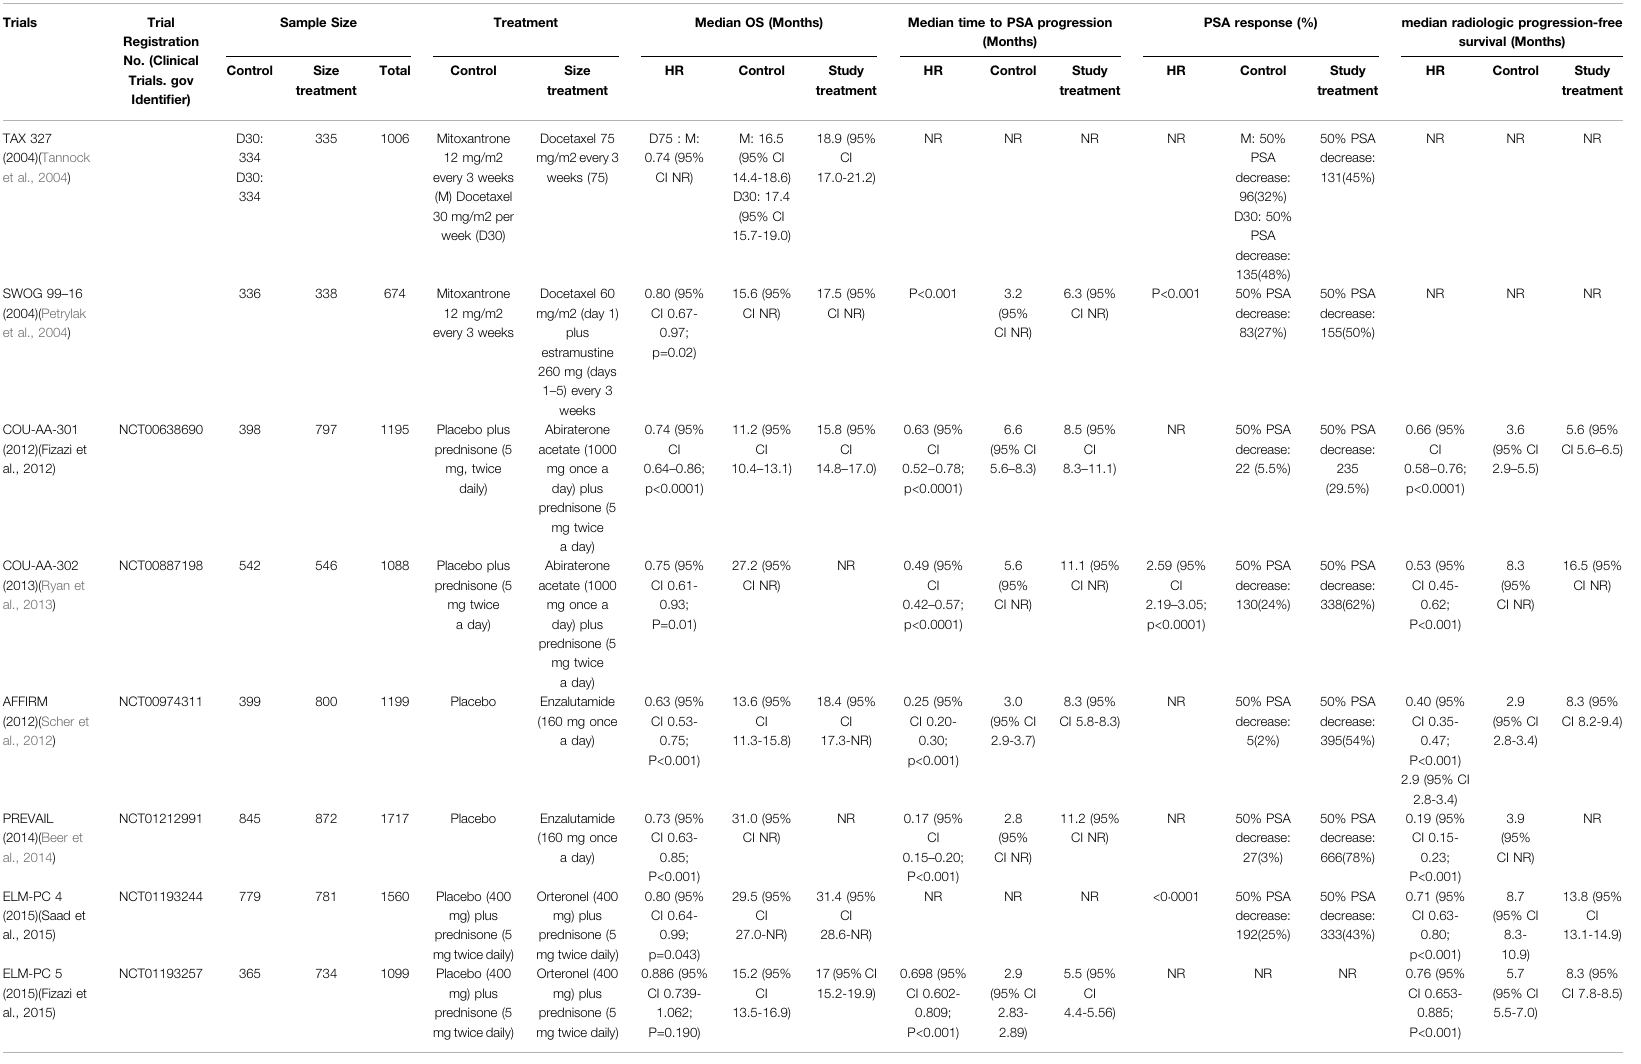
TABLE 1 | Phase 3 Trials in Metastatic Castration-Resistant Prostate